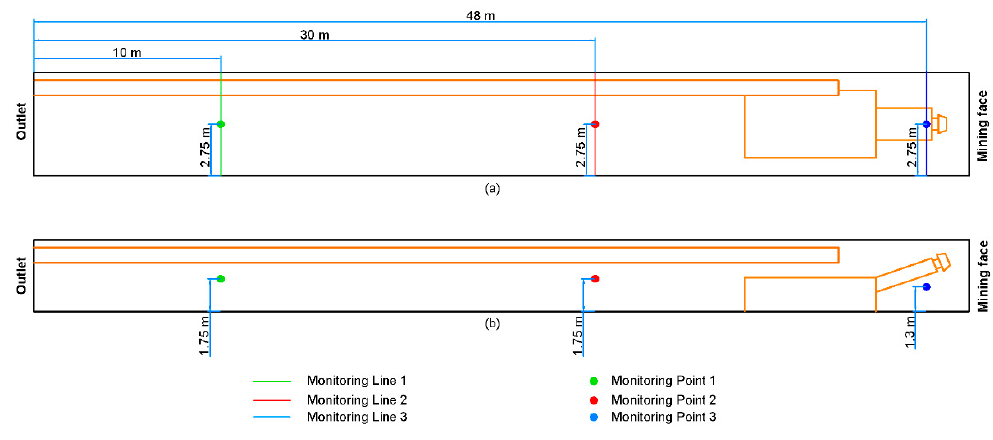
Figure 4. Laneway model using medium mesh.